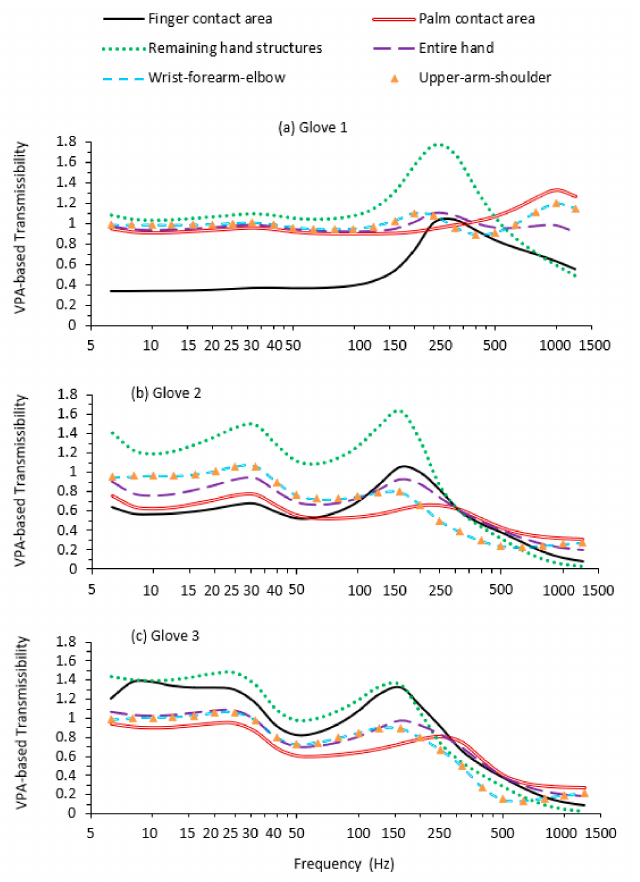
Figure 3. The ratios of gloved-VPA and ungloved-VPA in different substructures of the hand–arm system for the three gloves calculated using Equation (24): ( a ) Glove 1; ( b ) Glove 2; and ( c ) Glove